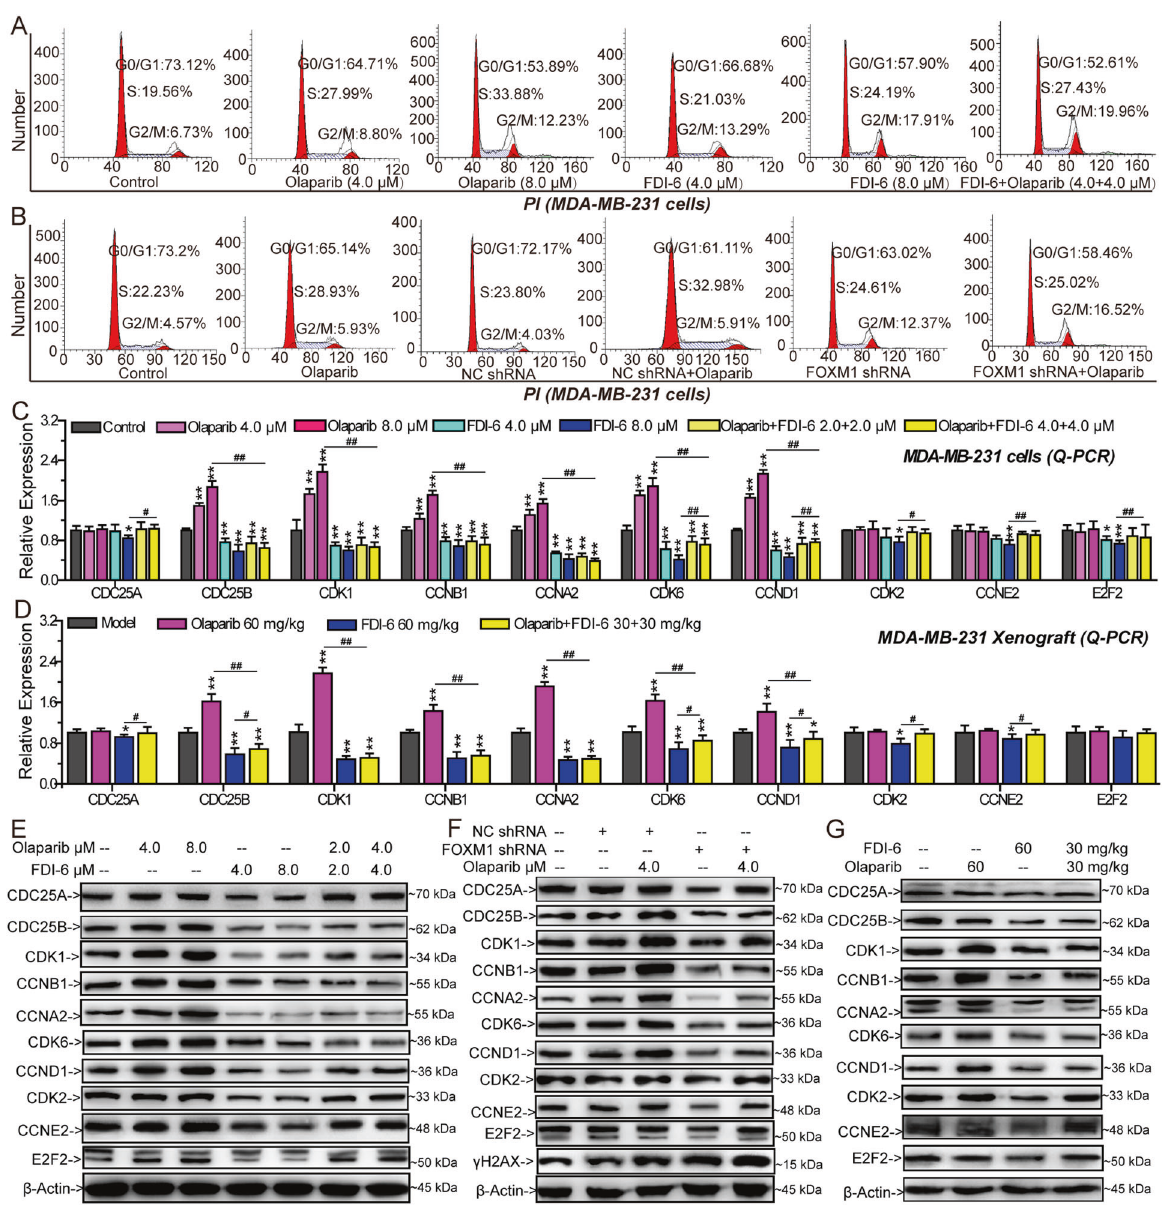
Fig. 5 The effects of FDI-6 and/or Olaparib on cell cycle progression and genes involved in cell cycle control. A The effects of FDI-6 and/or Olaparib on cell cycle progression in MDA-MB-231 cells. B The effects of FOXM1 shRNA and/or Olaparib on cell cycle progression in MDA-MB- 231 cells. Relative expression of genes involved in cell cycle control analyzed by Q-PCR in MDA-MB-231 cells ( C ) and MDA-MB-231 xenografts ( D ). E The effects of FDI-6 and/or Olaparib on the expression of proteins involved in cell cycle control analyzed by Western blots in MDA-MB- 231 cells. F The effects of FOXM1 shRNA and/or Olaparib on the expression of proteins involved in cell cycle control analyzed by Western blots in MDA-MB-231 cells. G The effects of FDI-6 and/or Olaparib on the expression of proteins involved in cell cycle control analyzed by Western blots in vivo. The results from three independent experiments were statistically analyzed using one-way ANOVA: * P < 0.05, ** P < 0.01 compared with the control; # P < 0.05, ## P < 0.01 compared with the FDI-6/Olaparib-combined group (FDI-6/Olaparib: 4.0 + 4.0 μ M, FDI-6/Olaparib: 30 + 30